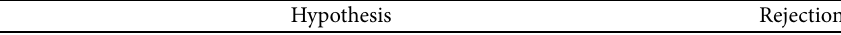
Table 5. Rejection of